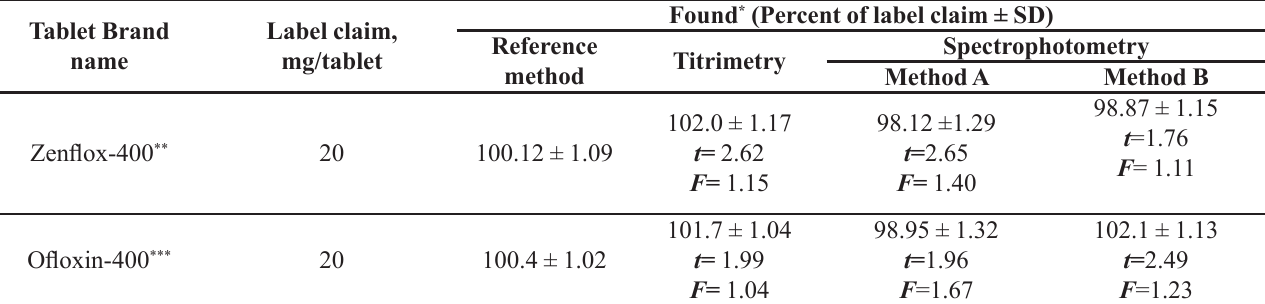
TABLE V - Results of analysis of tablets by proposed methods Tablet